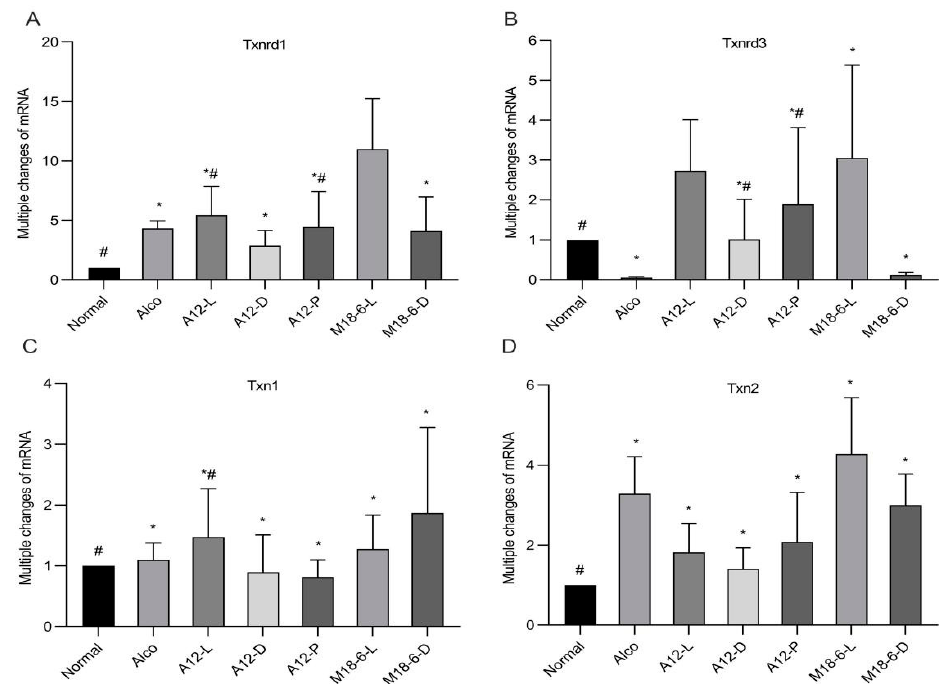
Figure 7. mRNA expression levels of thioredoxin system in livers of different groups. ( A ) Liver Txnrd1 mRNA expression level; ( B ) Liver Txnrd3 mRNA expression level; ( C ) Liver Txn1 mRNA expression level; ( D ) Liver Txn2 mRNA expression level. Compared with normal group ( p < 0.05) *, compared with Alco group ( p < 0.05) #. Txnrd1: thioredoxin reductase 1; Txnrd3: thioredoxin reduc- tase 3; Txn1: thioredoxin 1; Txn2: thioredoxin 2. Normal: normal saline-fed; Alco: alcohol-fed group; A12-L: alcohol-fed with live B. animalis A12 cells group, A12-D: alcohol-fed with dead B. animalis A12 cells group, A12-P: alcohol-fed with B. animalis A12 freeze-dried power group, M18-6-L: alco- hol-fed with live L. salivarius M18-6 cells group, and M18-6-D: alcohol-fed with dead L. salivarius M18-6 cells group. 3.7. Effect of B. animalis A12 and L. salivarius M18-6 on Immune Proteins in Mice with Alcohol Injury